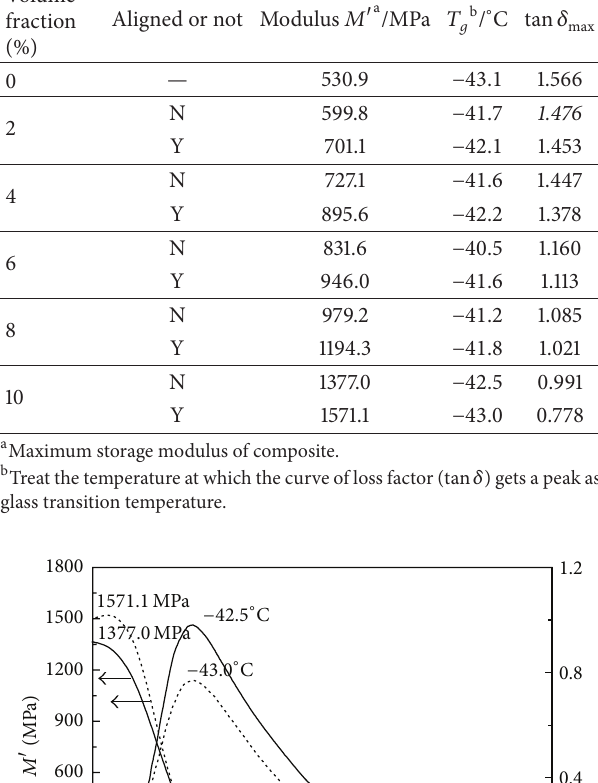
Table 3: Dynamic mechanical properties of composite with differ- ent MWCNT contents.